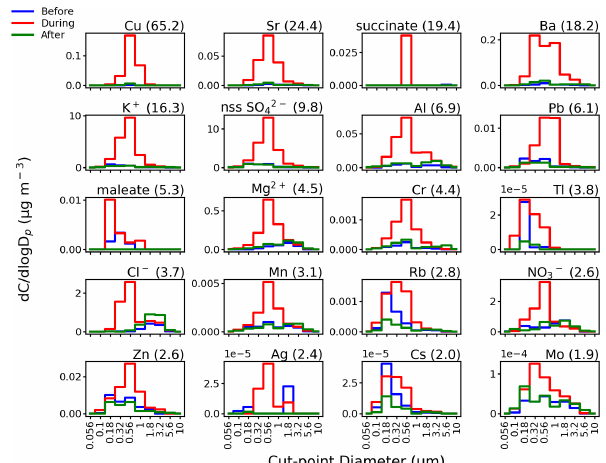
Figure 5. Speciated mass size distributions before (blue line), dur- ing (red line), and after (green line) the firework event. Next to species labels are bulk ( ≥ 0 . 056µm) mass concentration enrichment values due to the firework event; species are shown with enrich- ments ≥ 1 . 9. Figure S5 shows similar results for all other